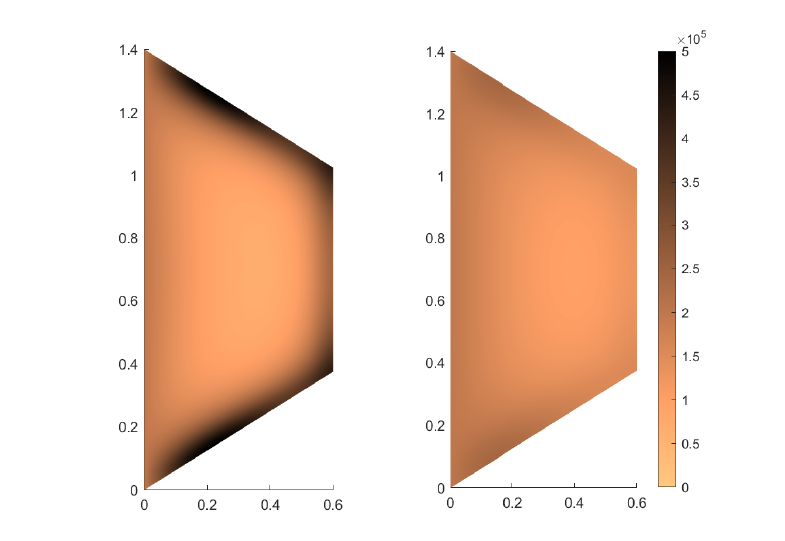
Figure 9. Concentration of osteogenic cells at the final time for the case of p m = 0.5 (left) and p m = 0.1 (right).